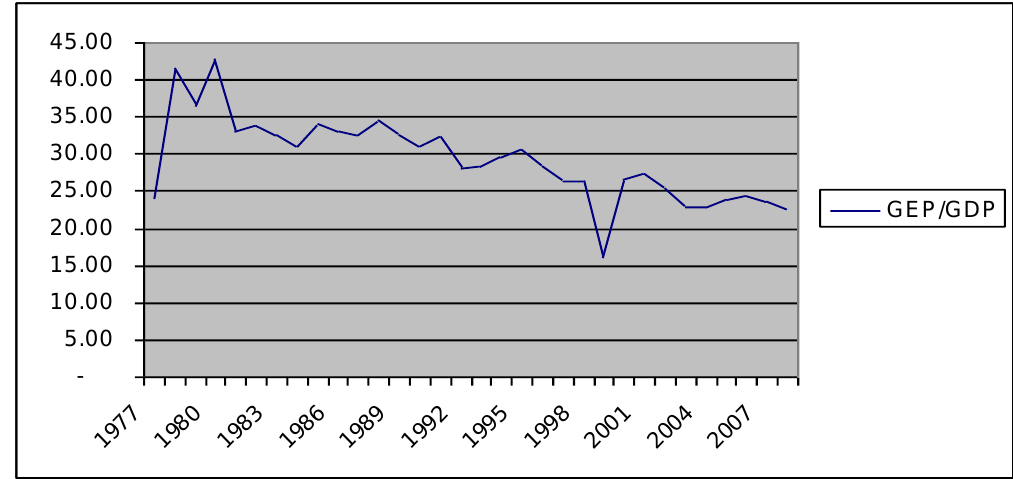
Figure 3: Government Expenditure (Percentage of GDP) Source: Central Bank of Sri Lanka, Annual Reports